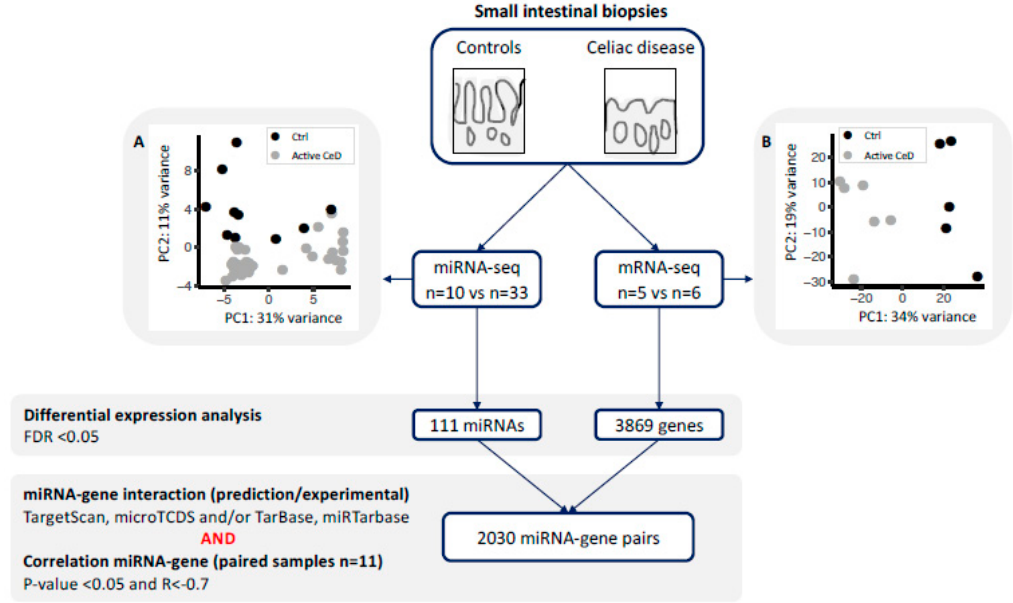
Figure 1. miRNA and gene expression profiles were generated for small-intestinal biopsies using a next generation sequencing approach. Principal component analysis using ( A ) the miRNA-seq profile and ( B ) the mRNA-seq analysis shows clear separation of controls (black) and active celiac disease (CeD) patients (grey). Differential expression analysis was performed between CeD and controls (FDR = p -value adjusted for multiple testing). For all the differentially expressed miRNAs and genes, we extracted previously described miRNA-target transcript interactions. In total, 2030 miRNA ‒ transcript target pairs remained with a negative Pearson’s correlation R < − 0.7.